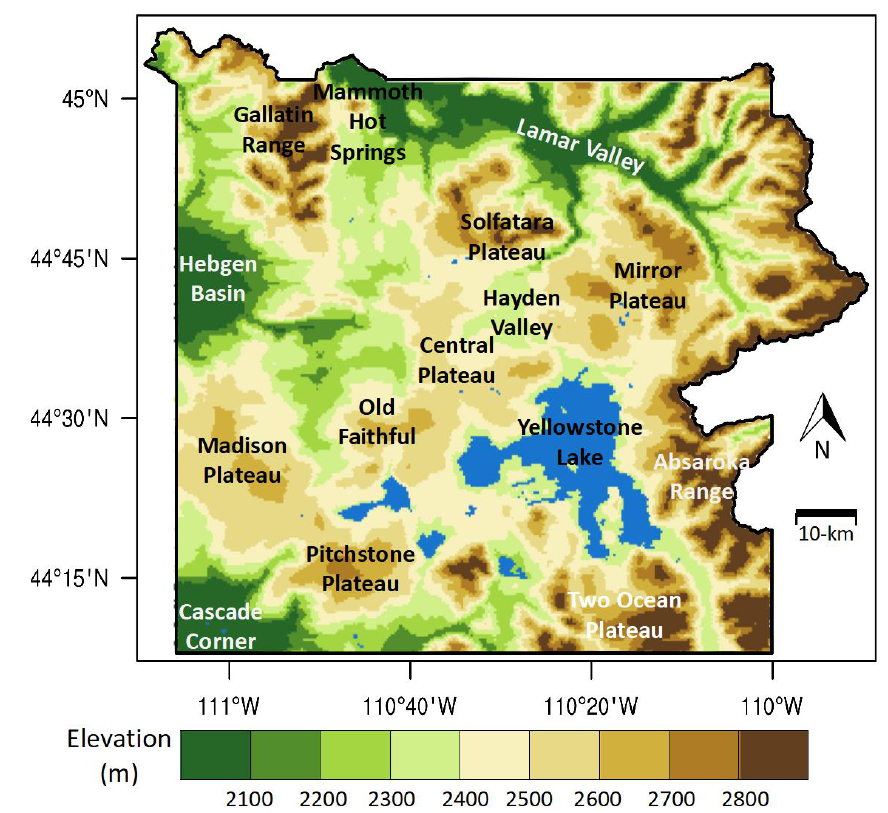
Figure 1. Elevation (m) across Yellowstone National Park based on the Parameter-elevation Regressions on Independent Slopes Model (PRISM) 800-m digital elevation model data. Key park regions are identified in text. Lakes are displayed in blue.